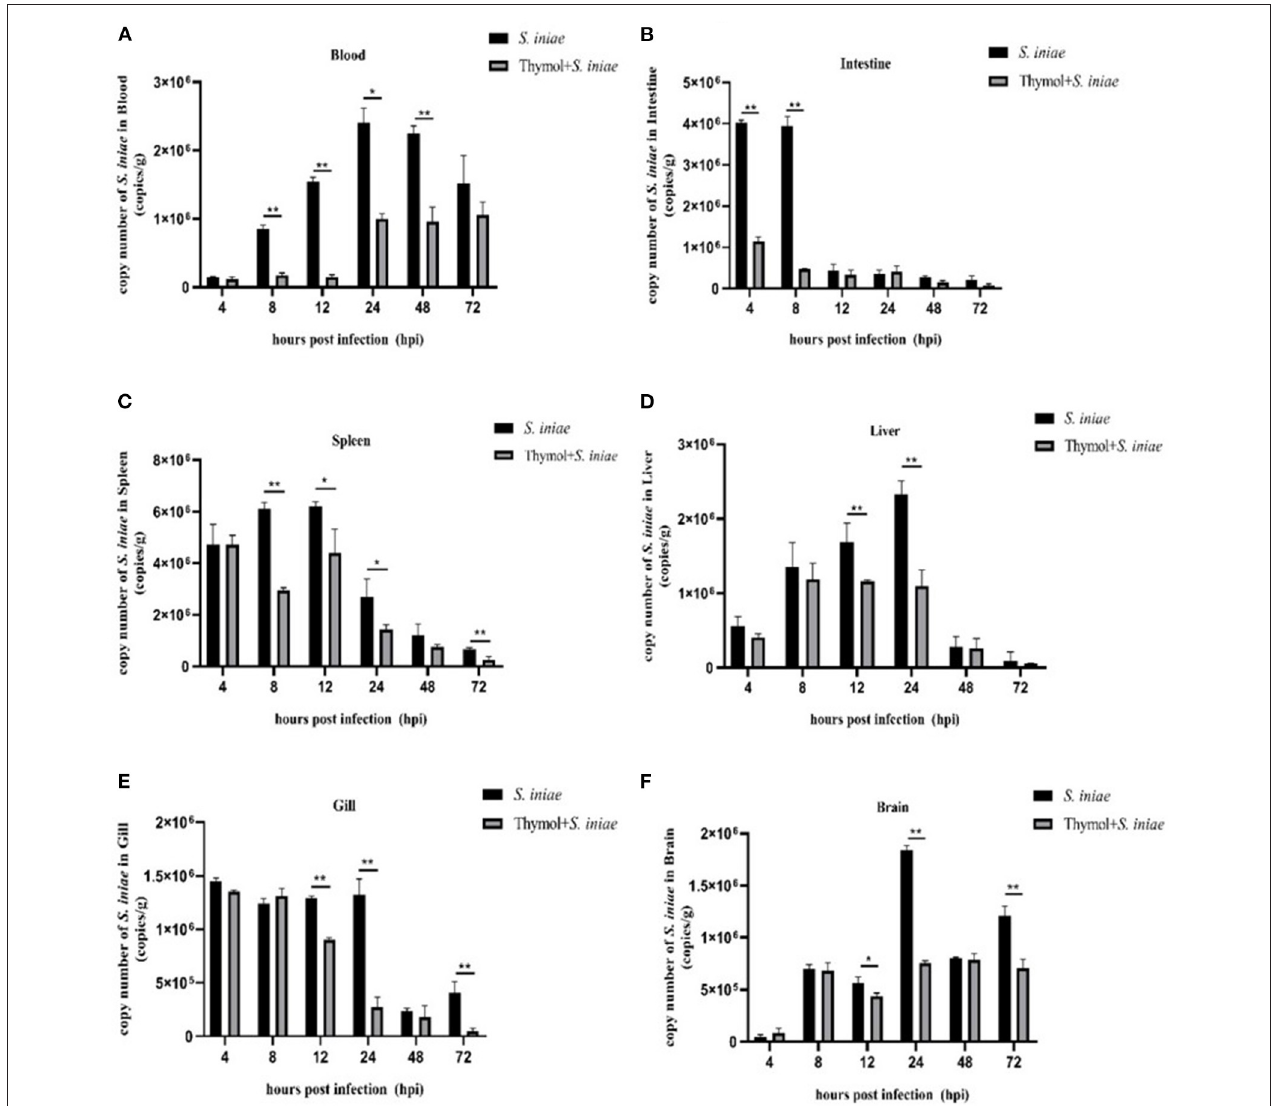
FIGURE 13 | Copy numbers of S. iniae in tissues of channel catfish. (A) Localization of S. iniae in blood; (B) Localization of S. iniae in intestine; (C) Localization of S. iniae in spleen; (D) Localization of S. iniae in liver; (E) Localization of S. iniae in gill; (F) Localization of S. iniae in brain. The X-axis represents hours post-challenge and the Y-axis represents the number copies of S. iniae per gram of tissue. The symbol ** represents an extremely significant difference ( P < 0.01); the symbol * represents a significant difference ( P <